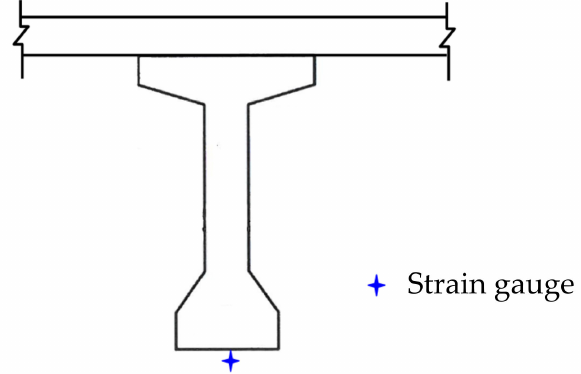
Figure 7. The deployment of the strain gauge for the dynamic